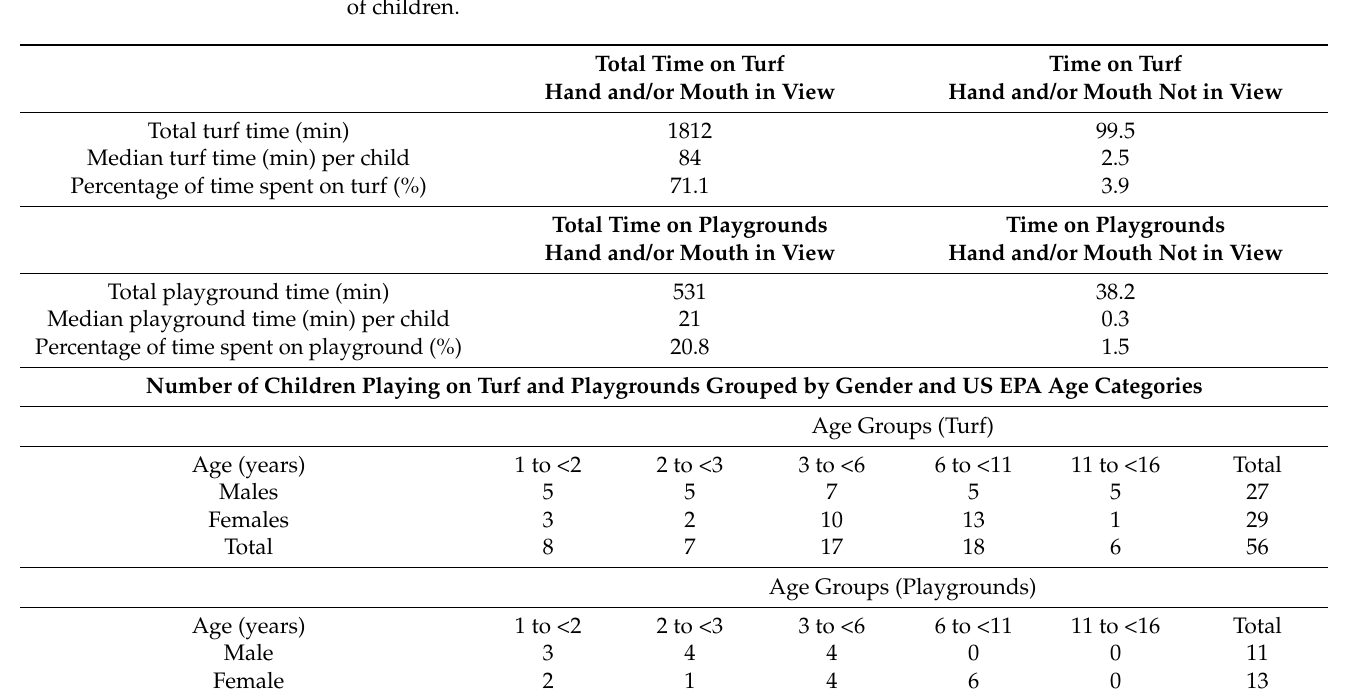
Table 2. Children’s videotaped time spent on turf (n = 56) and playgrounds (n = 24) and the number of